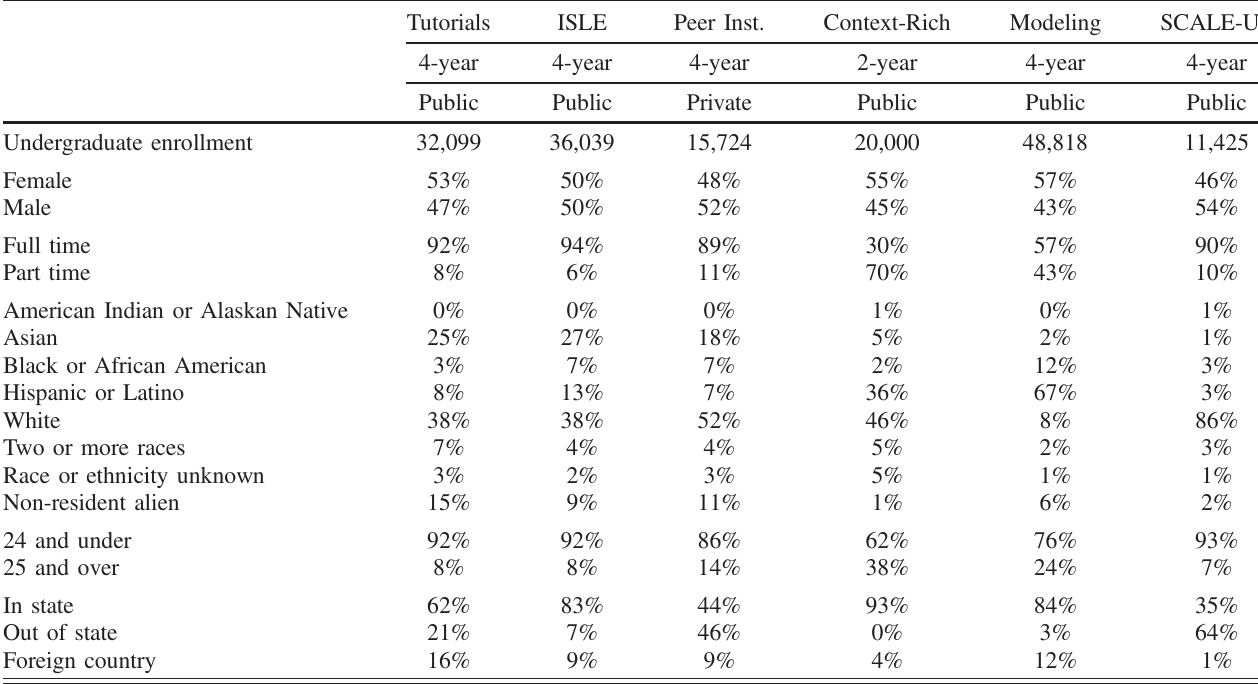
TABLE II. Institution-level demographics of research sites as provided by Integrated Post-Secondary Education Data System (IPEDS) [32]. Class-level demographics were not available for this study. For demographics that do not sum to 100%, the missing entries are “ unknown ”